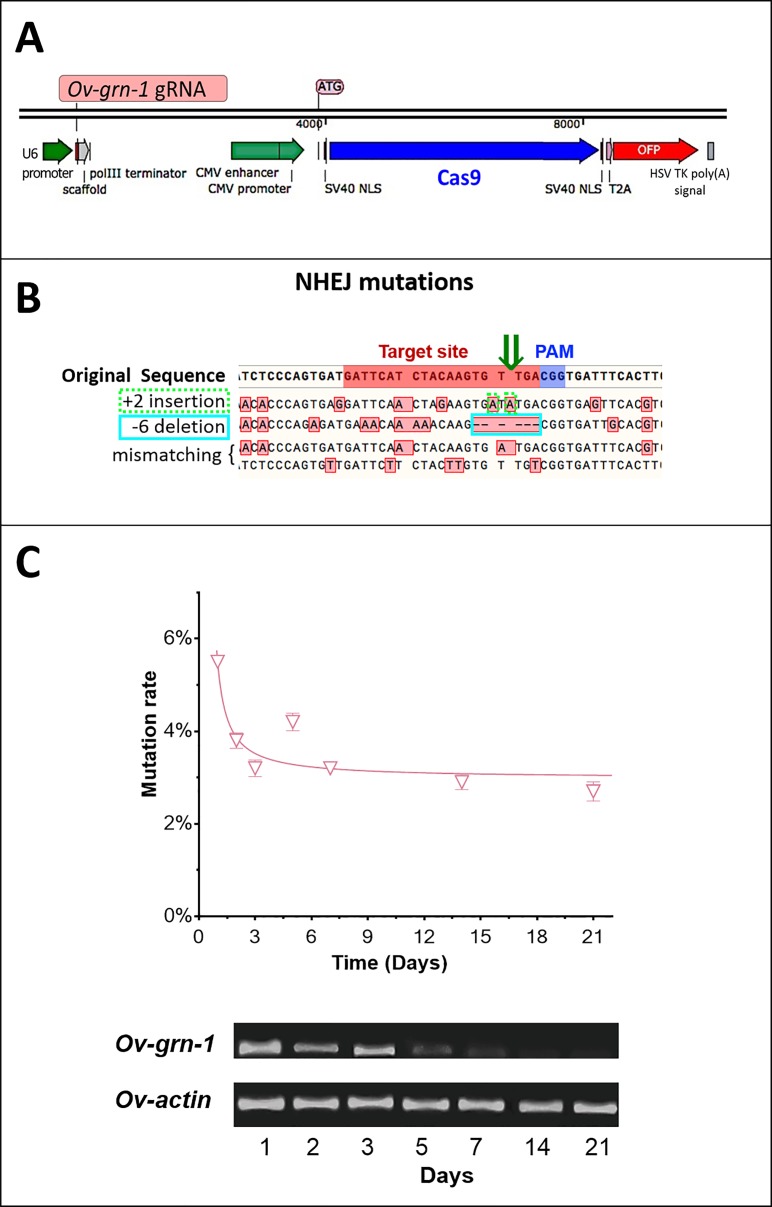
CRISPR/Cas9 targeting Ov-GRN-1 design and fluke transfection.(A) Ov-GRN-1 guide RNA insertion and Cas9 cassette. (B) The reference (WT) Ov-GRN-1 sequence with the target (red bar) and PAM (blue bar) sites highlighted. The dark green arrow indicates the programmed CRISPR/Cas cleavage site. Deep sequencing was used to determine specific mutations; the four sequences below the reference sequence provide examples of mutated Ov-GRN-1 genes; variations with red-boxed bases highlight mutations induced by the CRISPR/Cas9 manipulation. All four examples show a range of insertion, deletion or mismatch mutations boxed in red. The ‘+2 insertion’ with a dotted light green box highlights two alanine insertions near the programmed target site. The ‘−6 deletion’ highlights six absent base pairs with a light blue box that includes the target site. (C) The mutation rates were estimated using qPCR at each time point of ΔOv-GRN-1 adult flukes cultured in vitro and the means and standard deviations were determined. Gel of RT-qPCR products following electrophoresis (lower image) revealed that Ov-GRN-1 RNA levels were reduced in ΔOv-GRN-1 adult flukes.